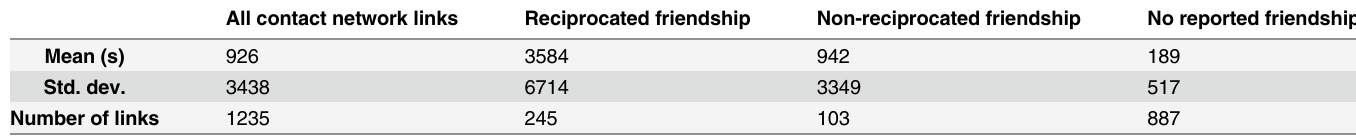
Table 6. Mean and standard deviation of distribution of aggregate durations for different sets of links (as in Fig 6(b)). All contact network links Reciprocated friendship Non-reciprocated friendship No reported friendship Mean (s) 926 3584 942 189 Number of